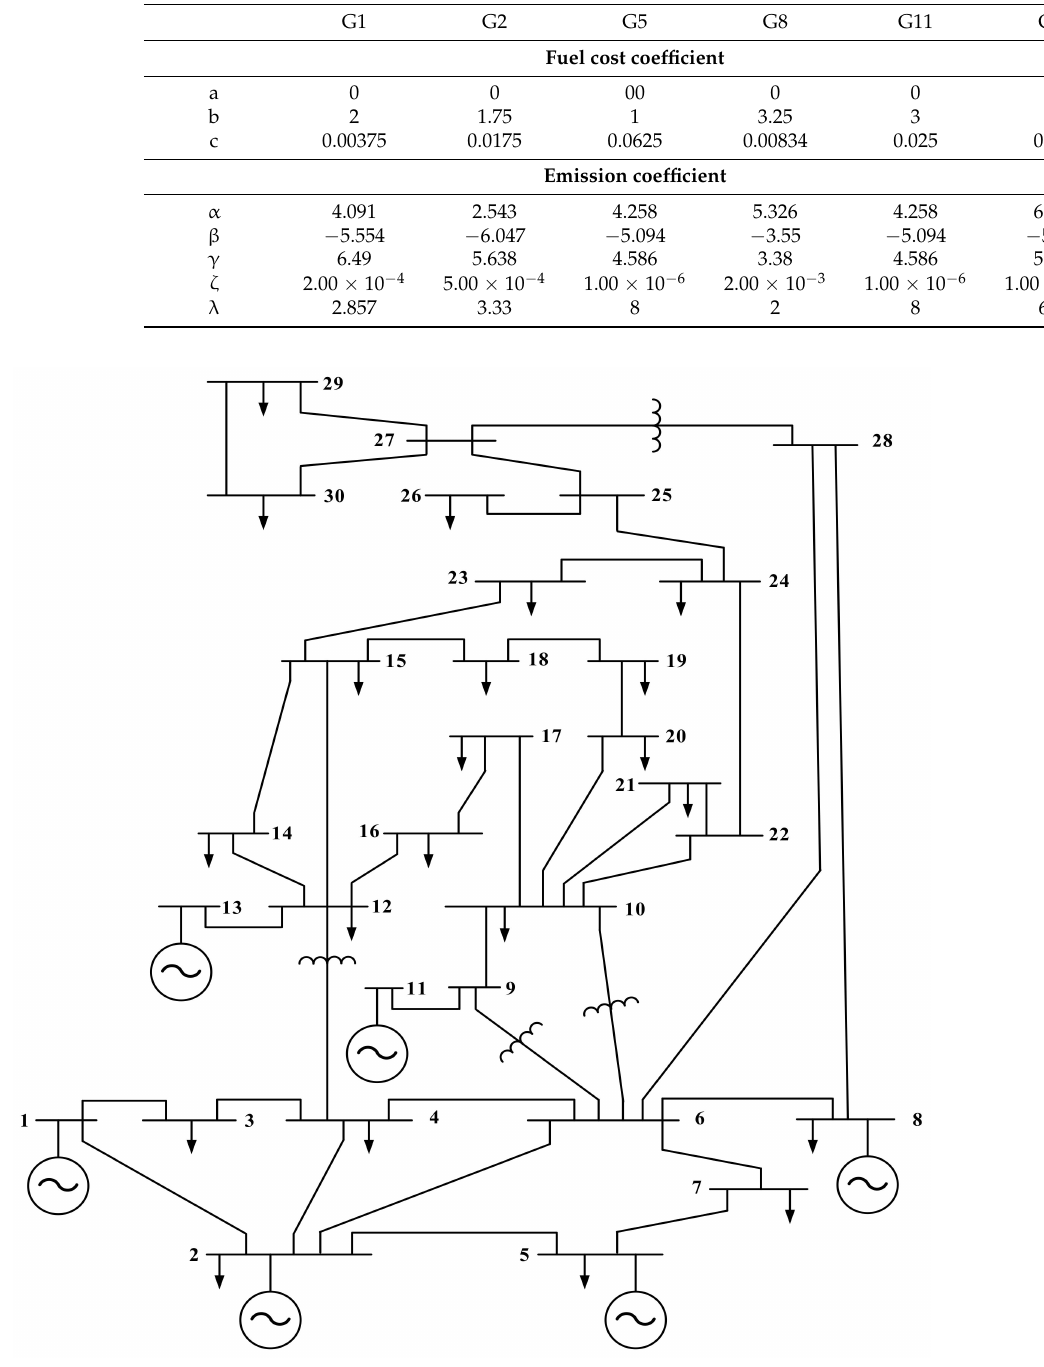
Figure A1. Single-line diagram of the IEEE 30-bus